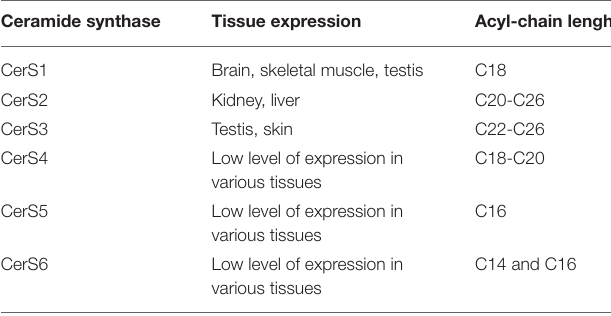
TABLE 1 | Comparison of ceramide synthases (CerS)